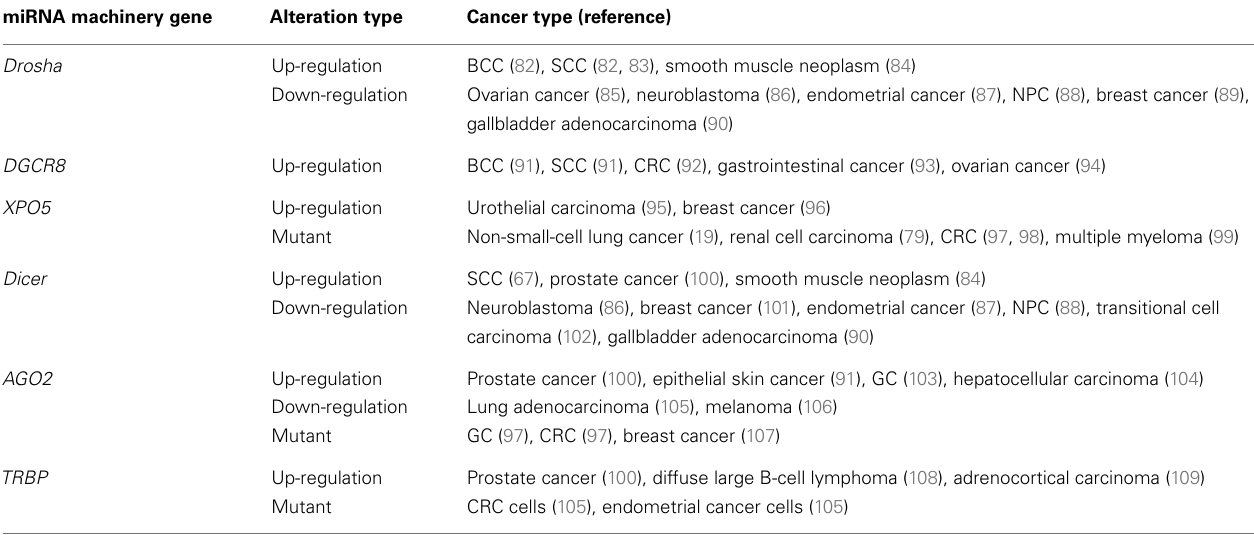
Table 3 | Expression levels of microRNA machinery genes in human tumors